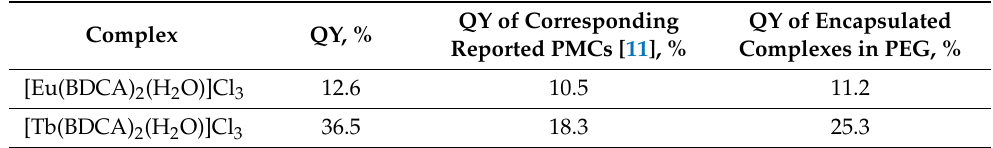
Table 1. QY values for [Eu(BDCA) 2 (H 2 O)]Cl 3 and [Tb(BDCA) 2 (H 2 O)]Cl 3 complexes compared to